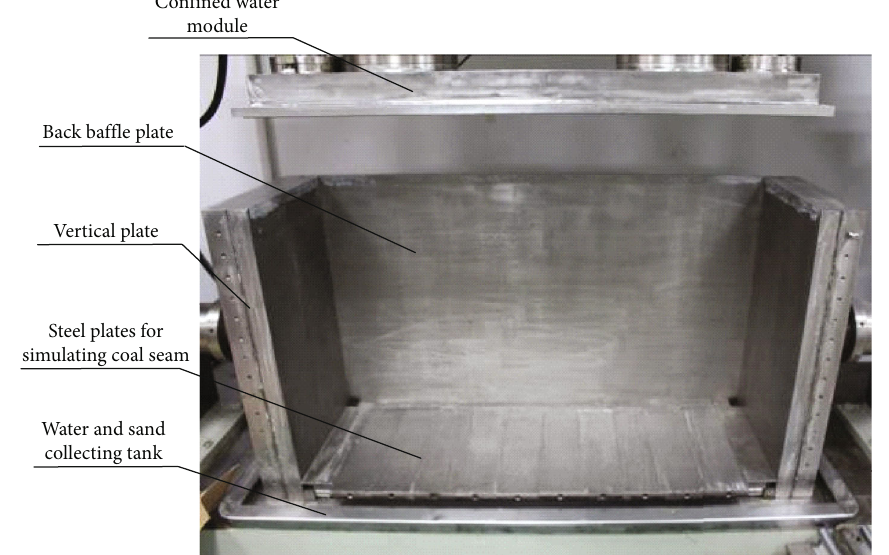
Figure 2: Structural diagrams of laboratory